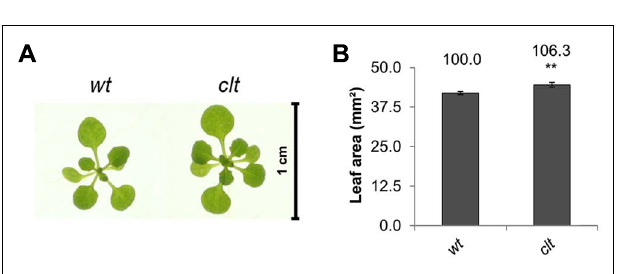
absence (control) or presence of the oxidative stress caused by the addition of paraquat (PQ) or high salt (sodium chloride, NaCl), or osmotic stress (sorbitol).The asterisks indicate significant differences ( p < 0.05; ANOVA).